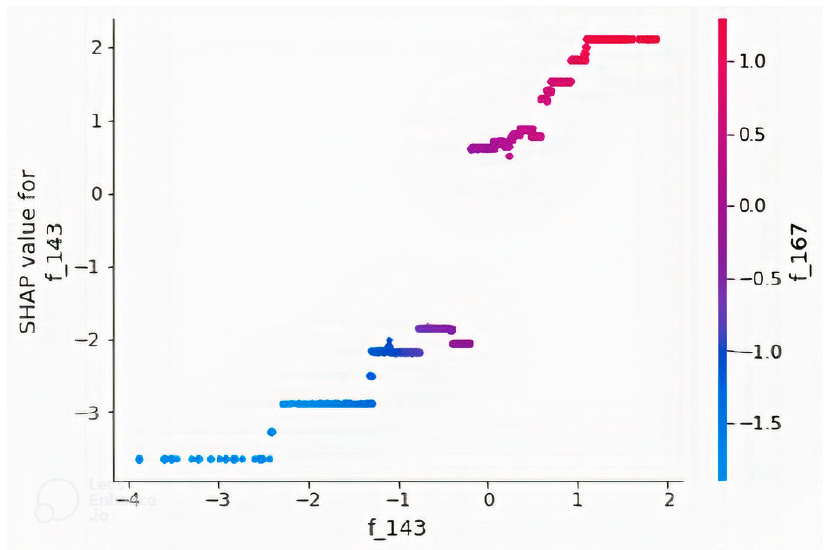
Figure 11. Dependence plot of the feature “f_143” in the model developed with a combination of non-image features and CNN + GLCM features. Feature ”f_143“ has the highest interaction index with